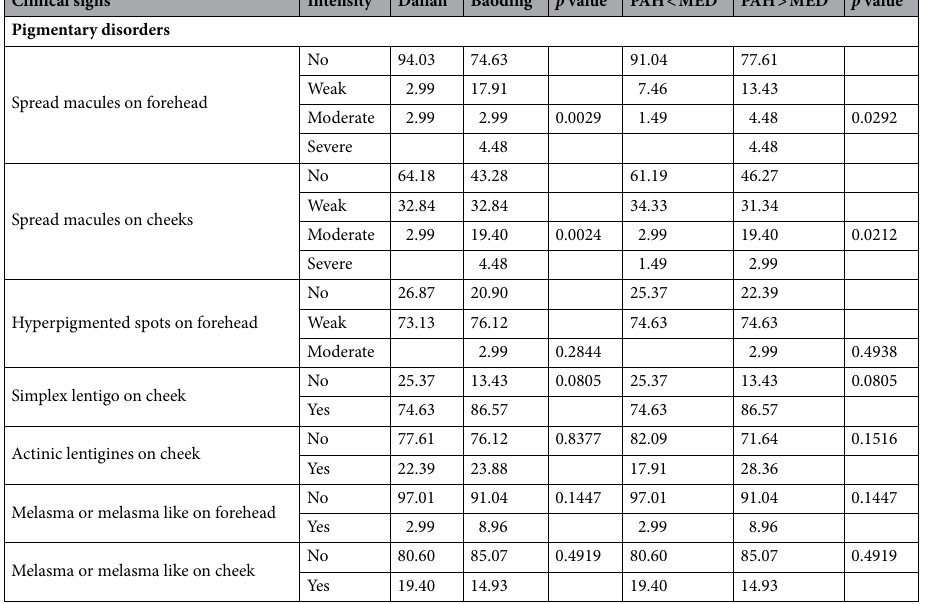
Table 1. Clinical facial signs for pigmentary disorders, their evaluation across Cities and PAH levels. PAH median corresponds to the median of the PAH score, the first component of a principal components analysis (PCA) on log-normalized PAH measurements. p values were calculated using either unpaired two-samples Wilcoxon or chi 2 tests depending on whether the clinical scores were ordinal or binary. The table was created using SAS version 9.4, SAS Institute Inc., Cary, NC,